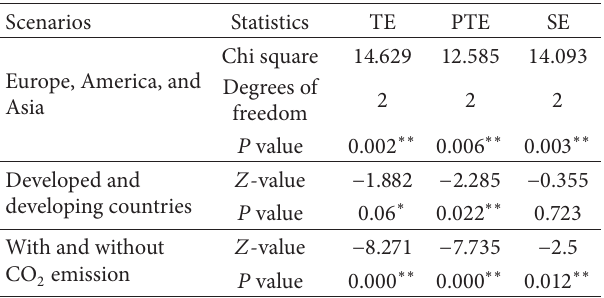
Table 3: Results of Kruskal-Wallis and Mann-Whitney 𝑈 test of different scenarios.